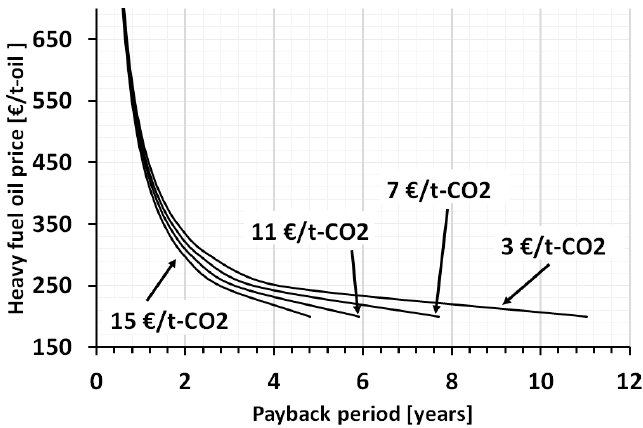
Figure 9. The payback periods when the CO 2 emission prices of 3, 7, 11 and 15 €/t-CO 2 are used. The inlet air temperature of the drying air is 80 °C. All other initial values are shown in Table 5.